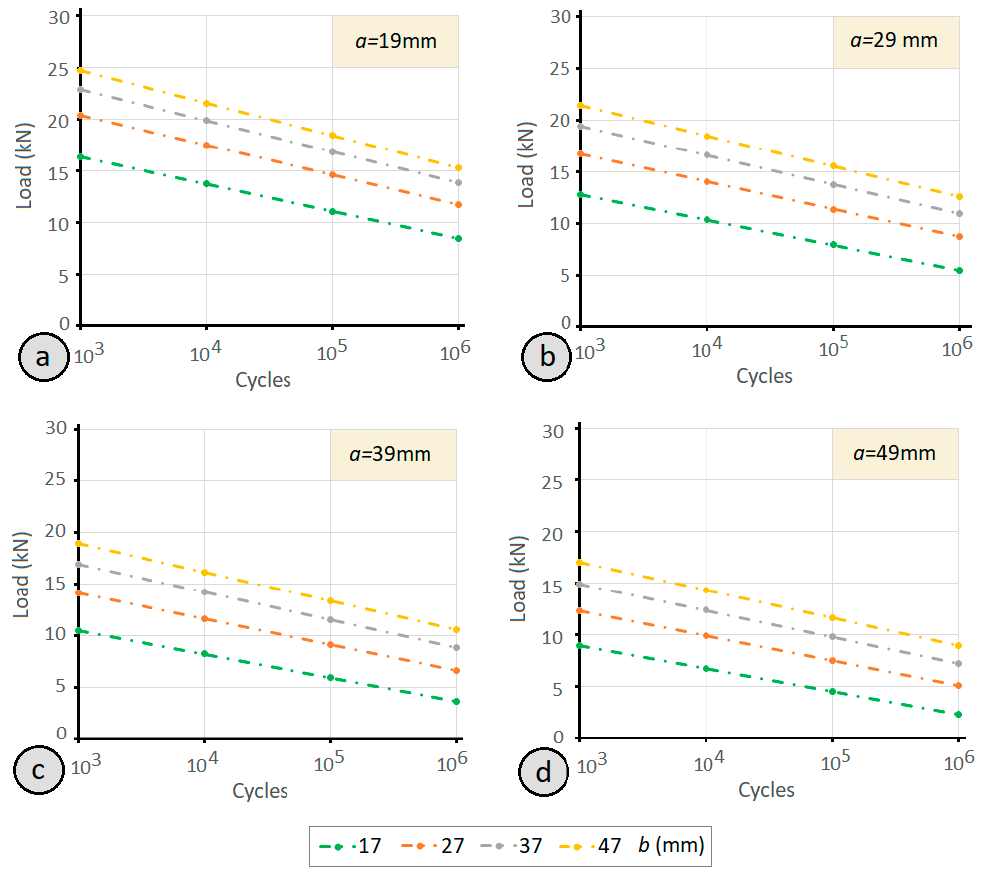
Figure 17. Variation of the fatigue limit of the clamp joint for different rear levers according to the size of the front lever and as a function of the number of life cycles: ( a ) front lever of 19 mm; ( b ) front lever of 29 mm; ( c ) front lever of 39 mm; ( d ) front lever of 49 mm.